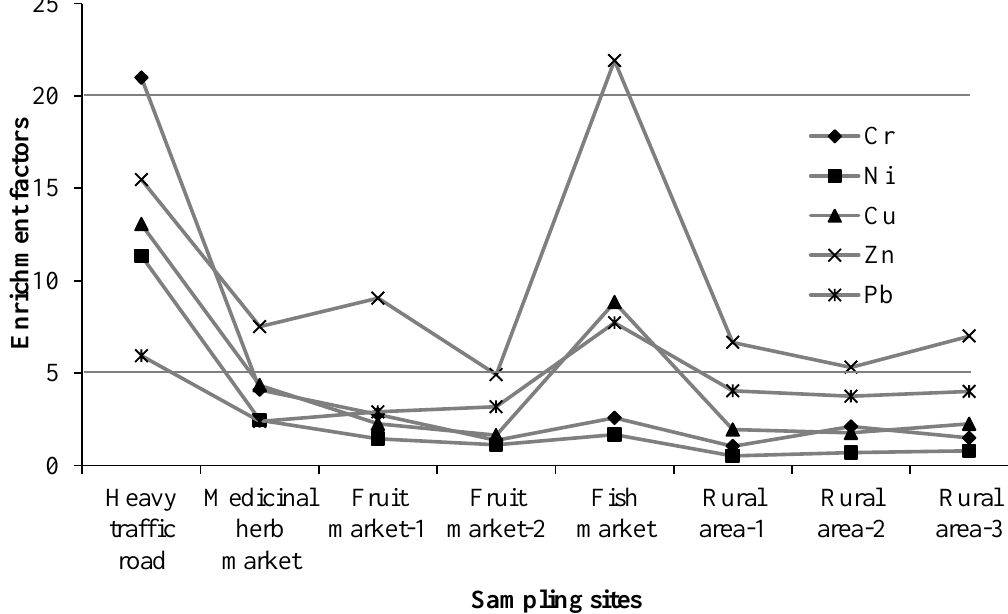
Figure 2. Enrichment factors of heavy metals in street dust samples.